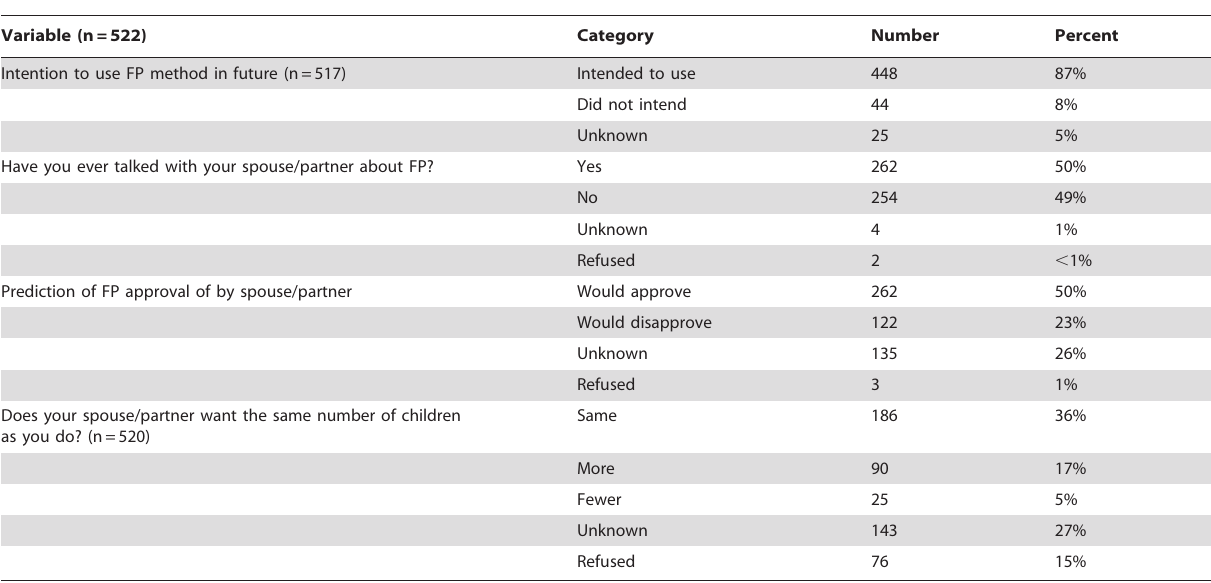
Table 2. Women’s Perception of Family Planning Acceptance by Spouse or Partner.*